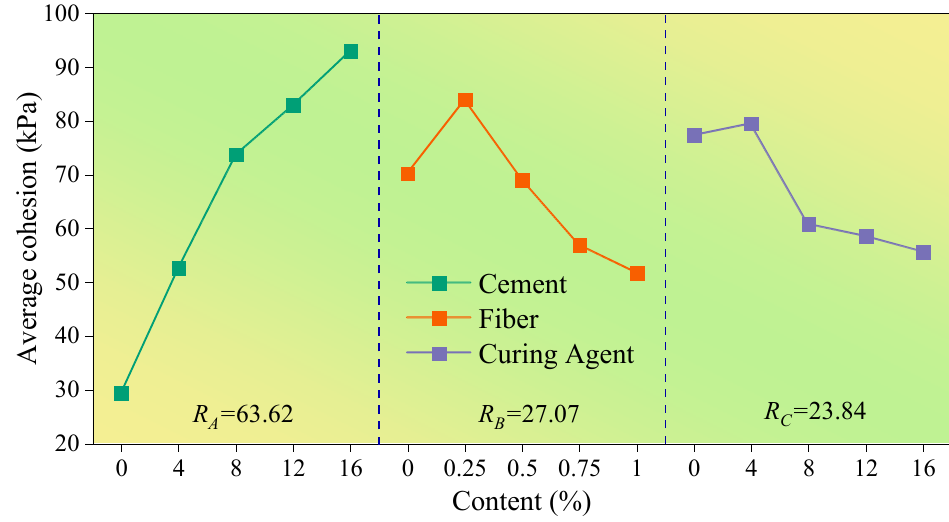
Figure 7. The influence of various factors on the cohesion.